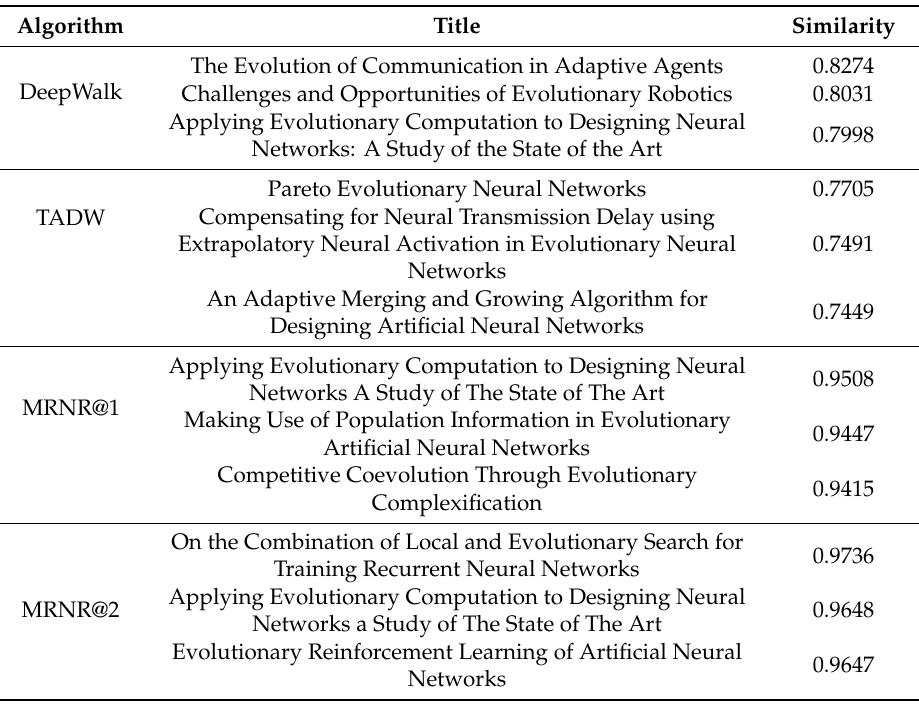
Table 10. Case study on the Citeseer